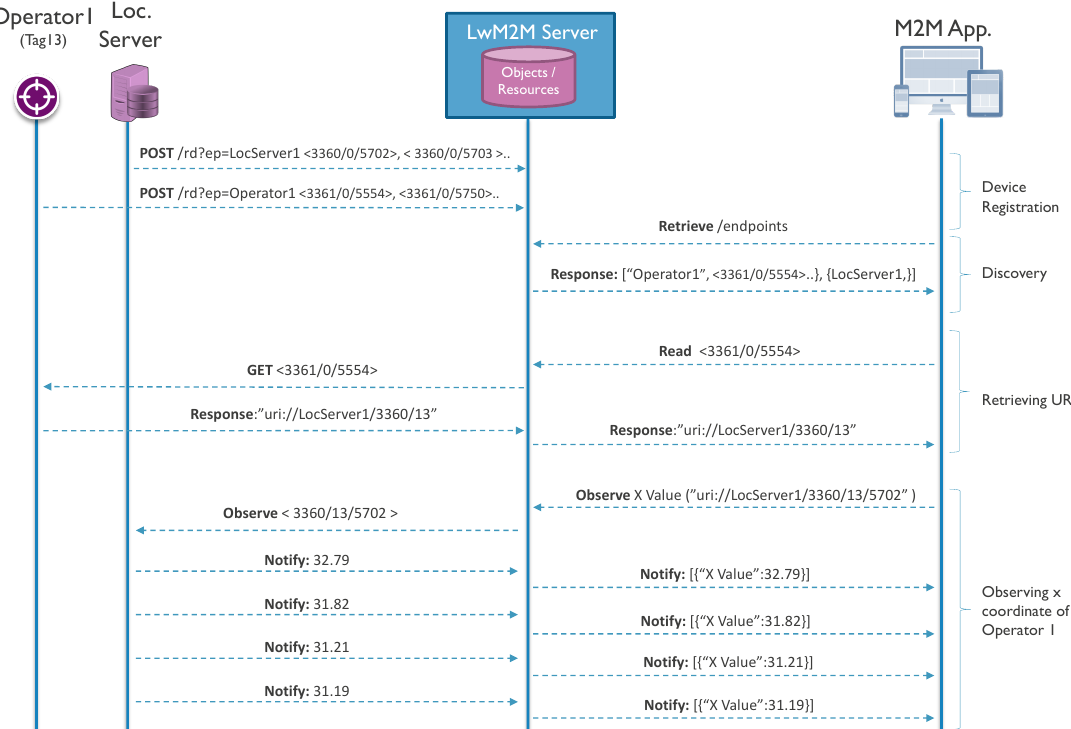
Figure 5. Infrastructure backend one-to-one interaction model: example